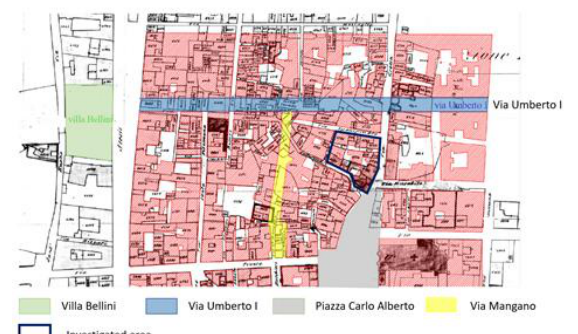
Figure 2 . Overlapping between current urban fabric (in red) and the cadastral map of 1876.